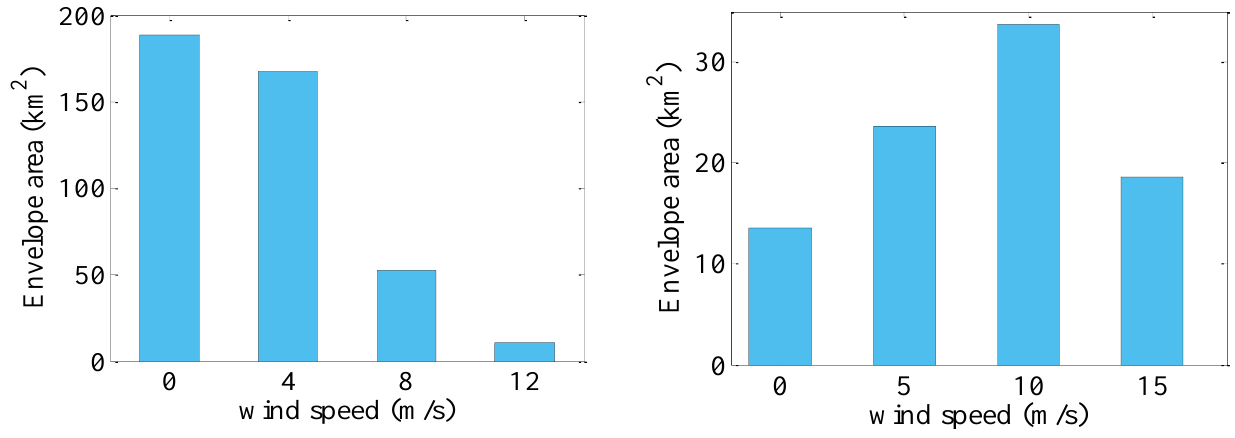
Figure 15. Surface area of 27 psu isohaline in the wet season ( right ) and the dry season ( left ).